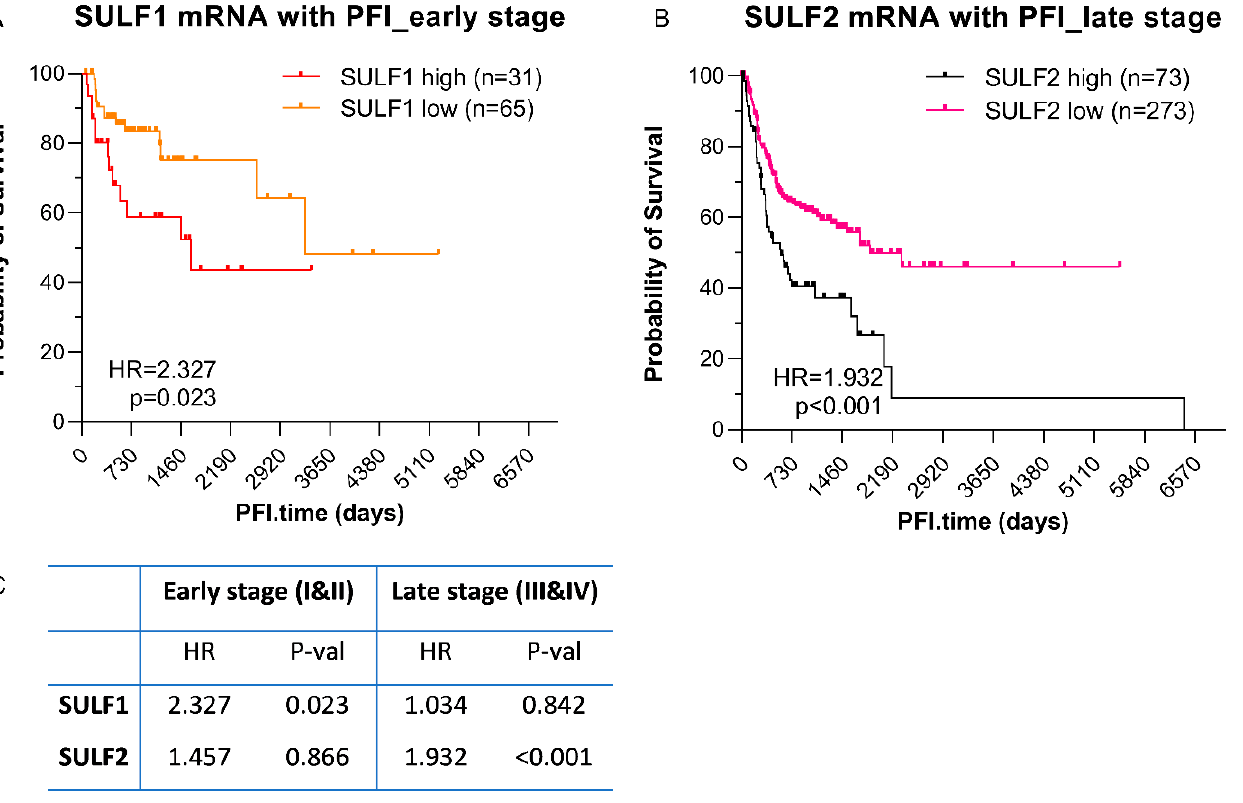
Figure 3. Impact of SULF1 and SULF2 expression on PFI of HNSC patients differs between early and late-stage tumors. ( A ) SULF1 is associated with PFI in early stage HNSC; ( B ) SULF2 is associated with PFI in late-stage HNSC. ( C ) Summary statistics of the PFI in the early and late-stage tumors.